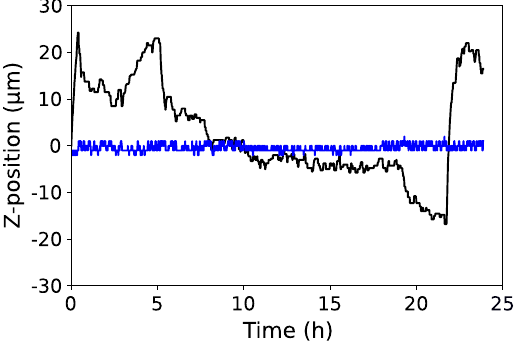
Figure 6. CNN controlled autofocusing during live-cell imaging of yeast. The (black) stage position and (blue) sample focal position over the course of a 24 hour growth